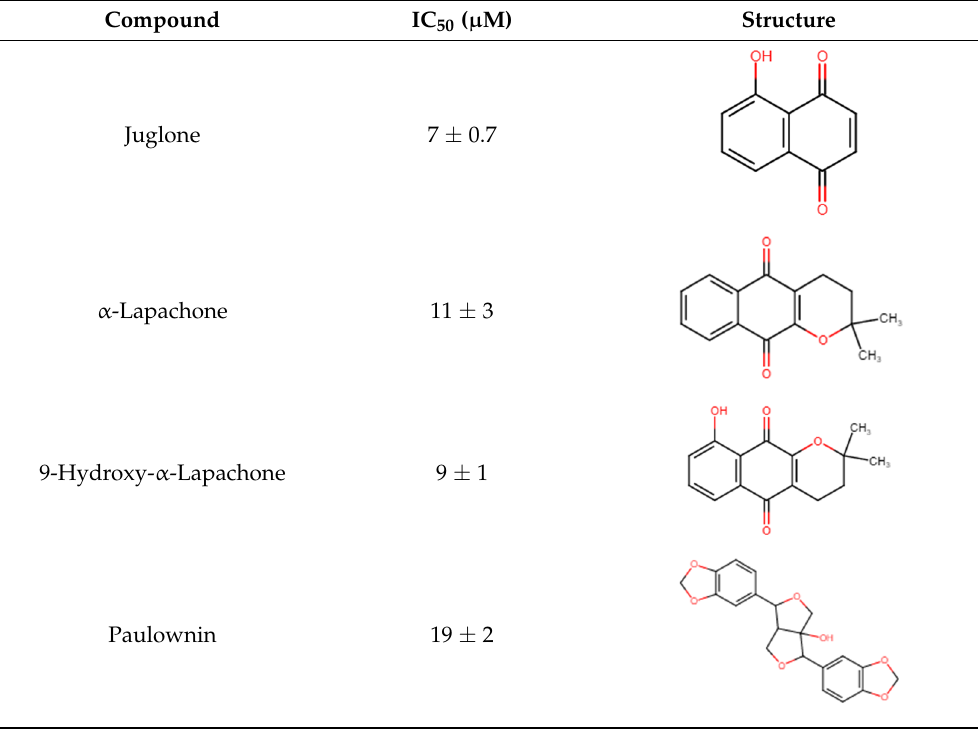
Table 1. The five known inhibitors of CGS of Helicobacter pylori with names, IC 50 values, and structures. Compound